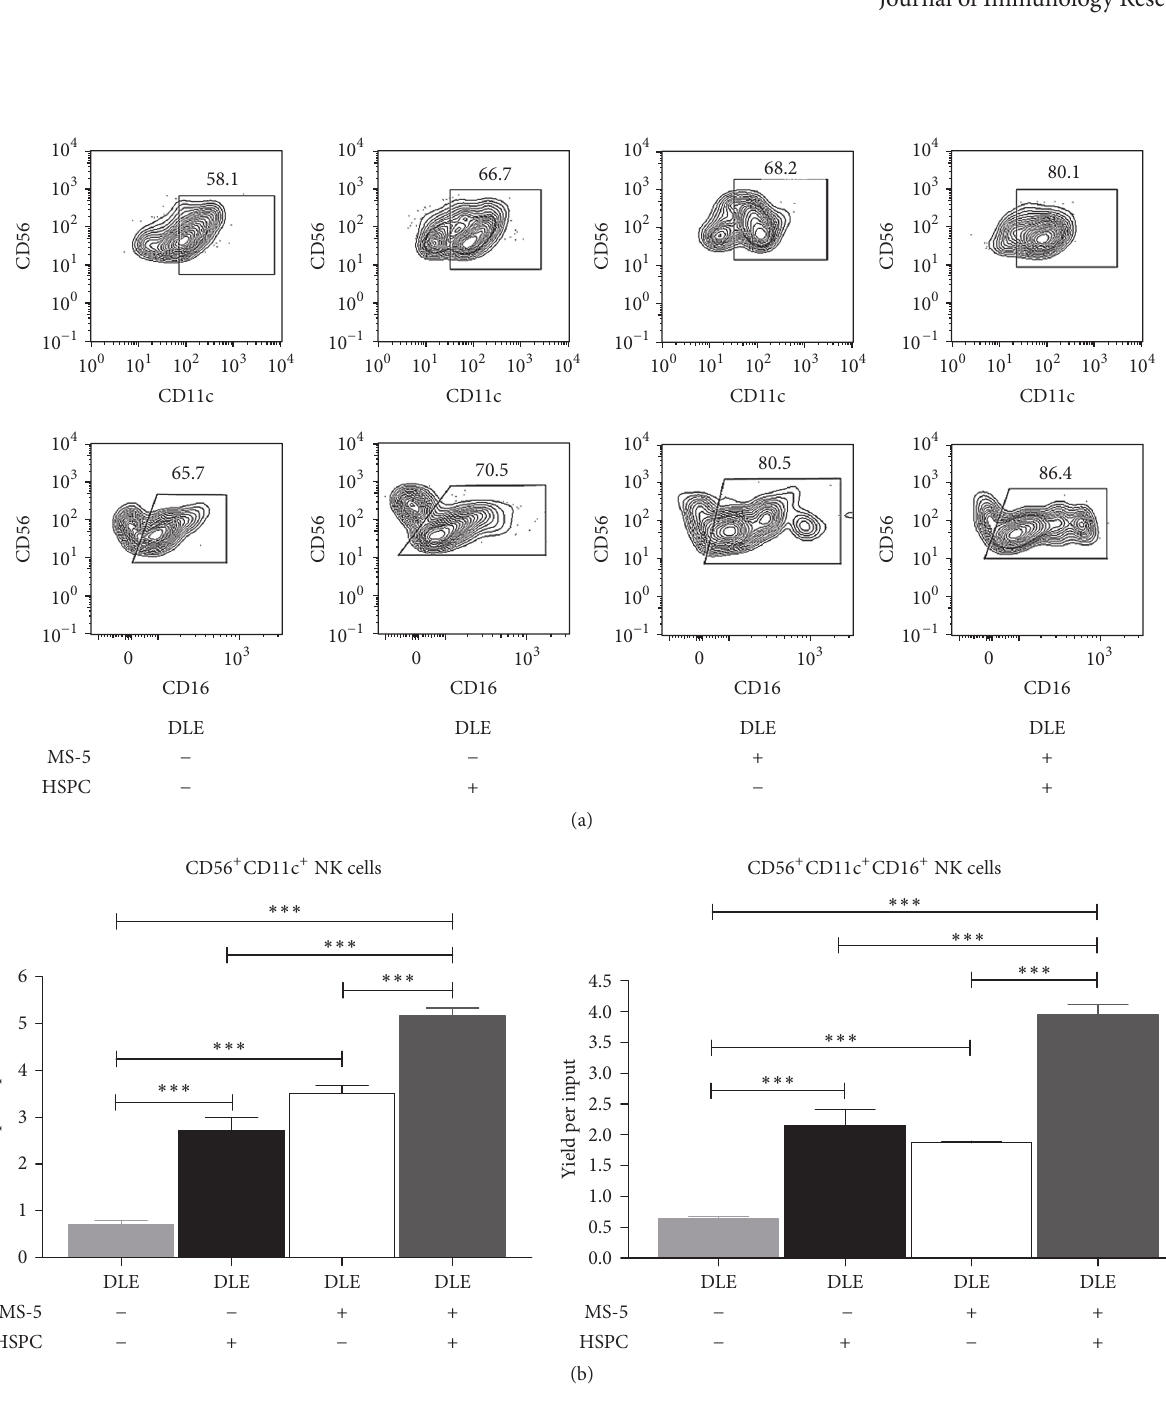
Figure 4: Preferential production of functional CD11c + CD16 + NK-like cells promoted by hematopoietic-stromal cell communication responding to DLE. MS-5 stromal cells were exposed or not to DLE Transferon 24 hours before coculturing with DLE Transferon- pretreated CD34 + hematopoietic stem and progenitor cells (HSPC), as described in Figure 3(a). All conditions were placed in lymphoid lineage cocultures for 30 days followed by flow cytometry analyses, where the indicated gates were used to discriminate CD56 + CD11c + and CD56 + CD16 + CD11c + NK cell frequencies (a). Yields per input progenitor were tabulated to record the significant variations by stromal or hematopoietic cells exposure to DLE Transferon (b). ∗∗∗ 𝑃 < 0.001